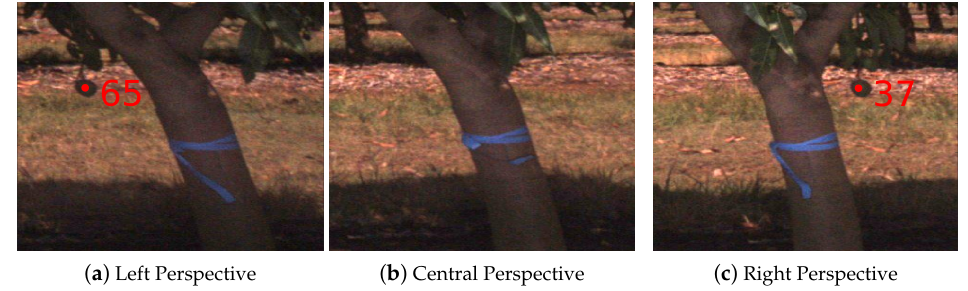
Figure 20. A single fruit is counted twice. The figure shows how a visible mango (65 in a ) becomes occluded behind the trunk ( b ) and is counted as a new mango (37 in c ) when